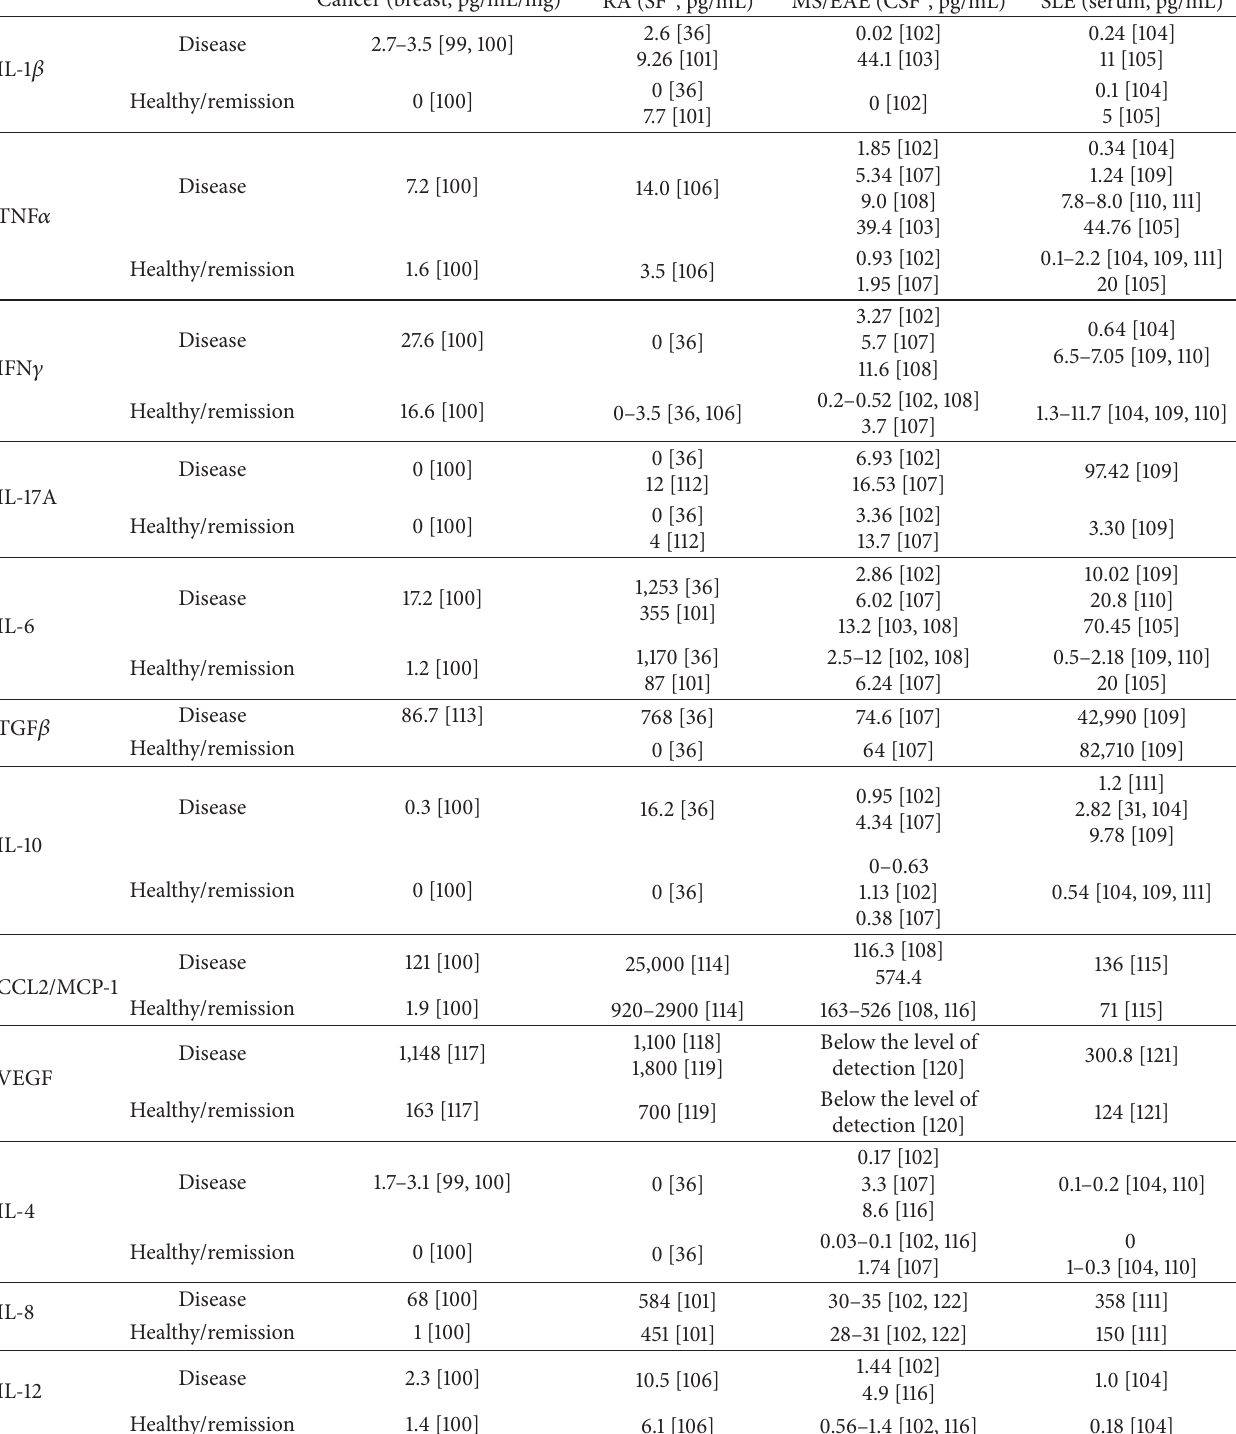
Table 3: Example concentrations of cytokines and chemokines in the